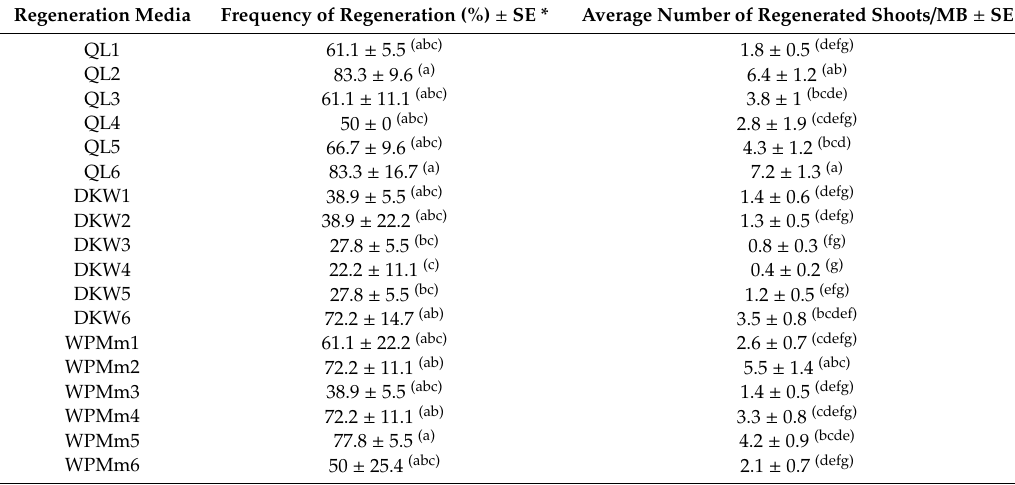
Table 1. Regeneration e ffi ciency obtained from Hansen 536 MB slices after four weeks of culture on di ff erent combinations of basal media and PGRs.